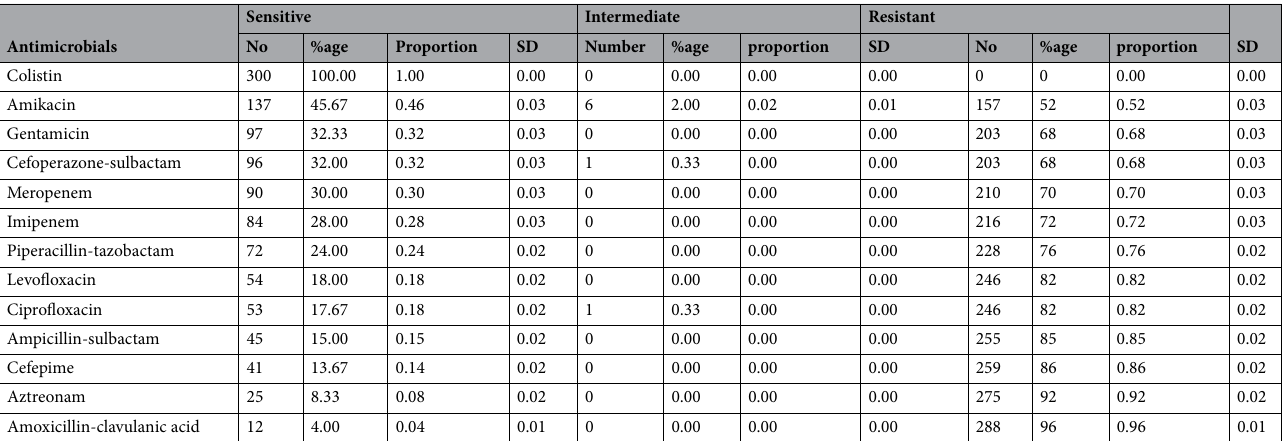
Table 3. Antimicrobial sensitivity pattern against K. pneumoniae from burn wound patients (N = 300).